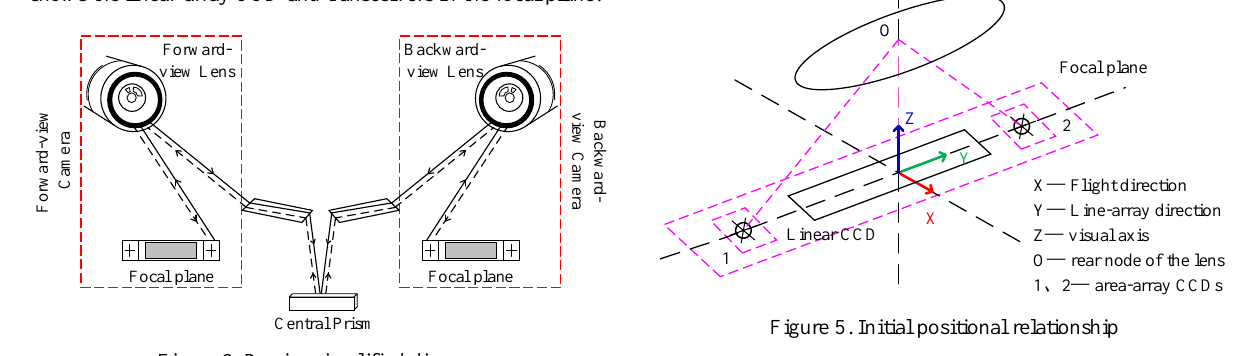
Figure 2. Device simplified diagram